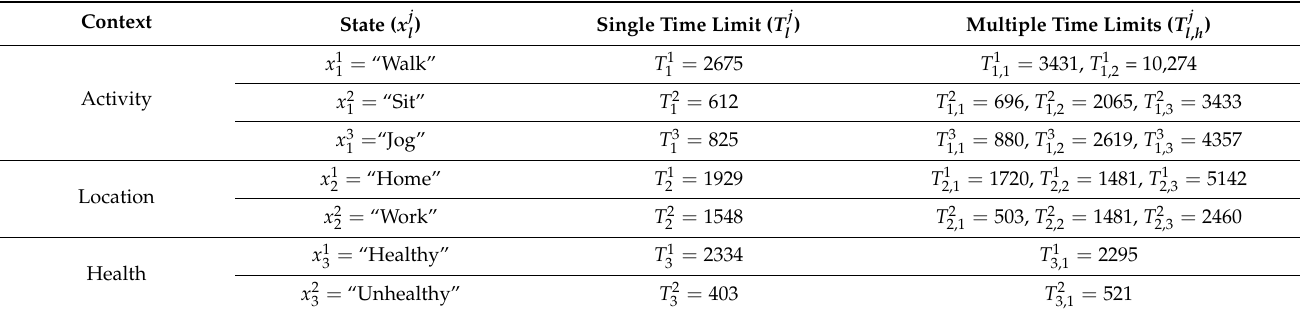
Table 2. User behavior time limits for different context